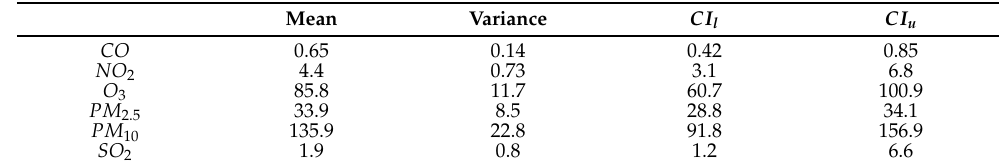
Table 9. The mean, variance and the confidence interval of the predicted concentrations for six air pollutants based on 1000 Monte Carlo experiments at Ma Lian Kou in